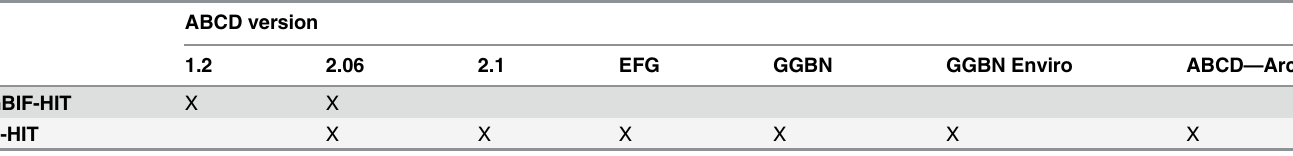
Table 1. ABCD versions supported by the GBIF-HIT and B-HIT.